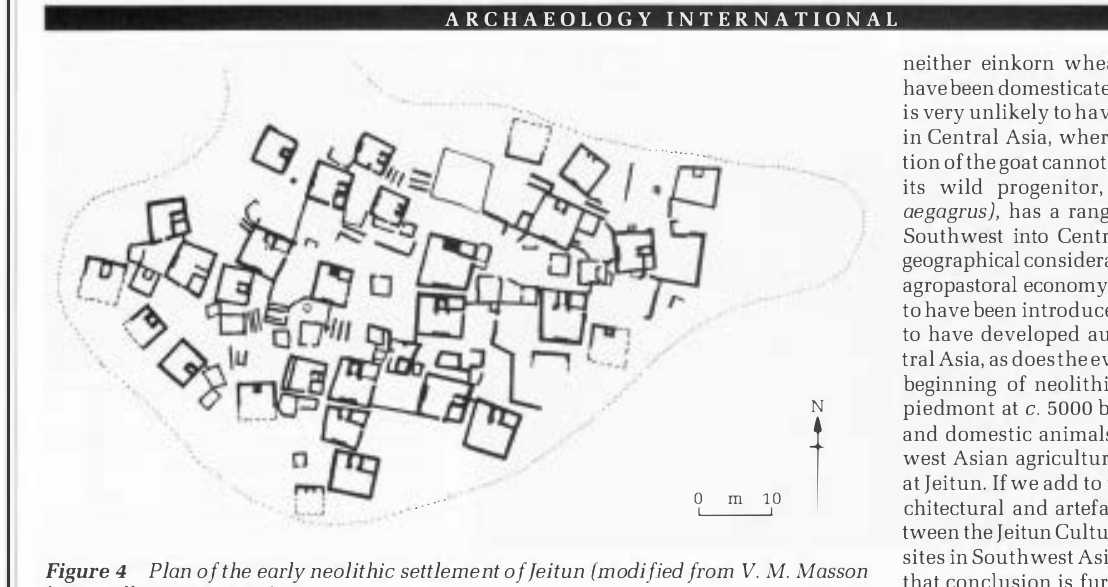
Figure 4 Plan of the early neolithic settlement of feitun (modified from V. M. Masson by f. Mellaart, n. 6: 213). of occupation, it was a small village of some 30 houses and a probable population of between 150 and 200.